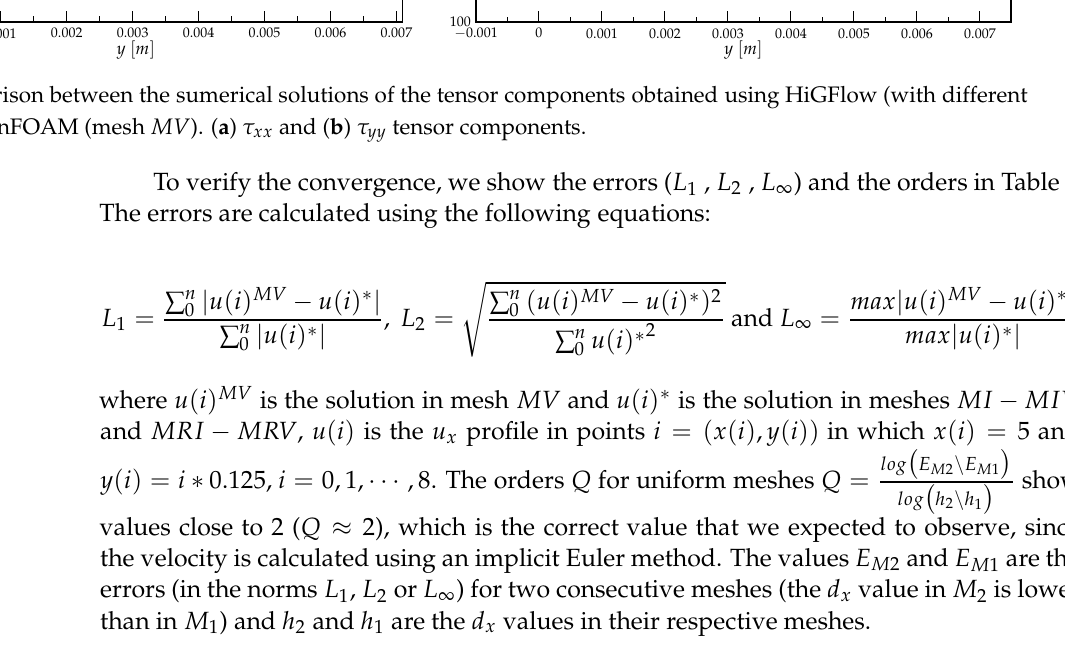
Table 5. Errors and orders for u-velocity. The mesh MV was assumed as a reference